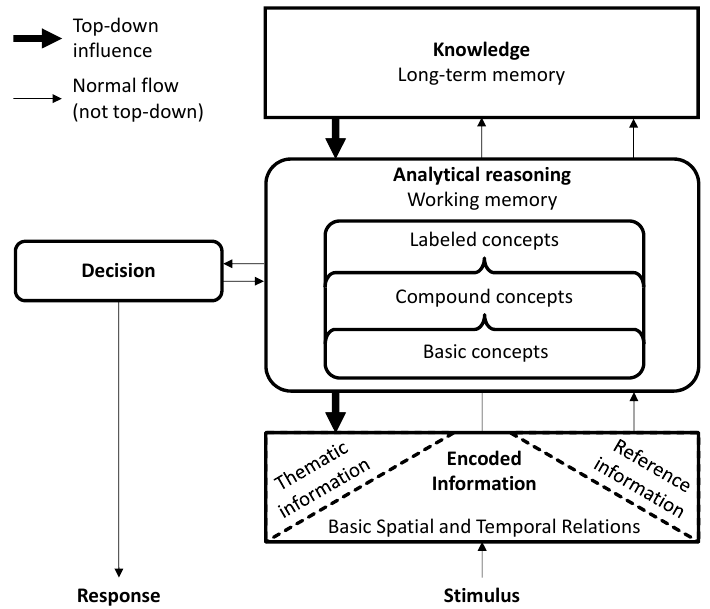
Figure 1: The human reasoning framework for spatiotemporal analysis. The flow of infor- mation starts with a stimulus and ends in a decision. Normal processing flow refers here to the traditional view of a one-directional flow of information in human perception. The components depicted in the diagram are explained in the text. The notation is inspired by Patterson et al.